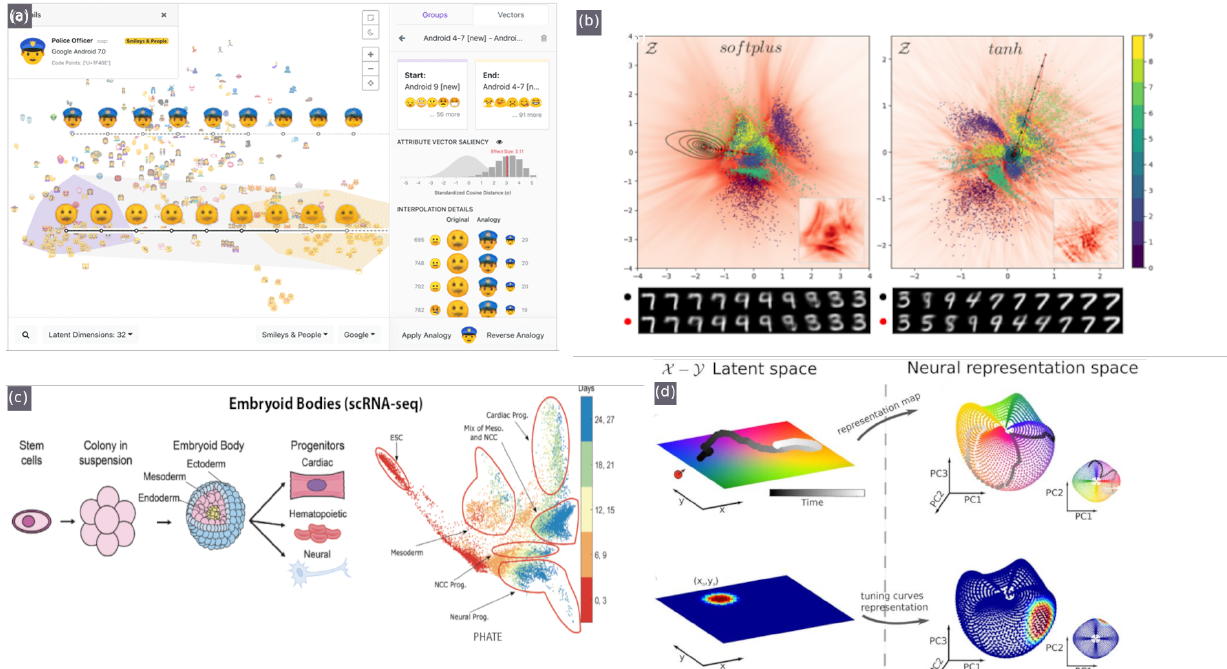
Figure 4. Latent space visualisation tools: ( a ) latent space cartography. Reproduced with permission [74]. ( b ) Generalised metric-inspired measures and measure-based transformations for generative models. Reproduced with permission [75]. ( c ) PHATE. Reproduced with permission [77]. ( d ) Manifold analysis for navigation tasks, where a navigating agent learns to predict the upcoming sensory observation, and the dynamical and geometrical properties are captured in a neural representation manifold. Reproduced with permission